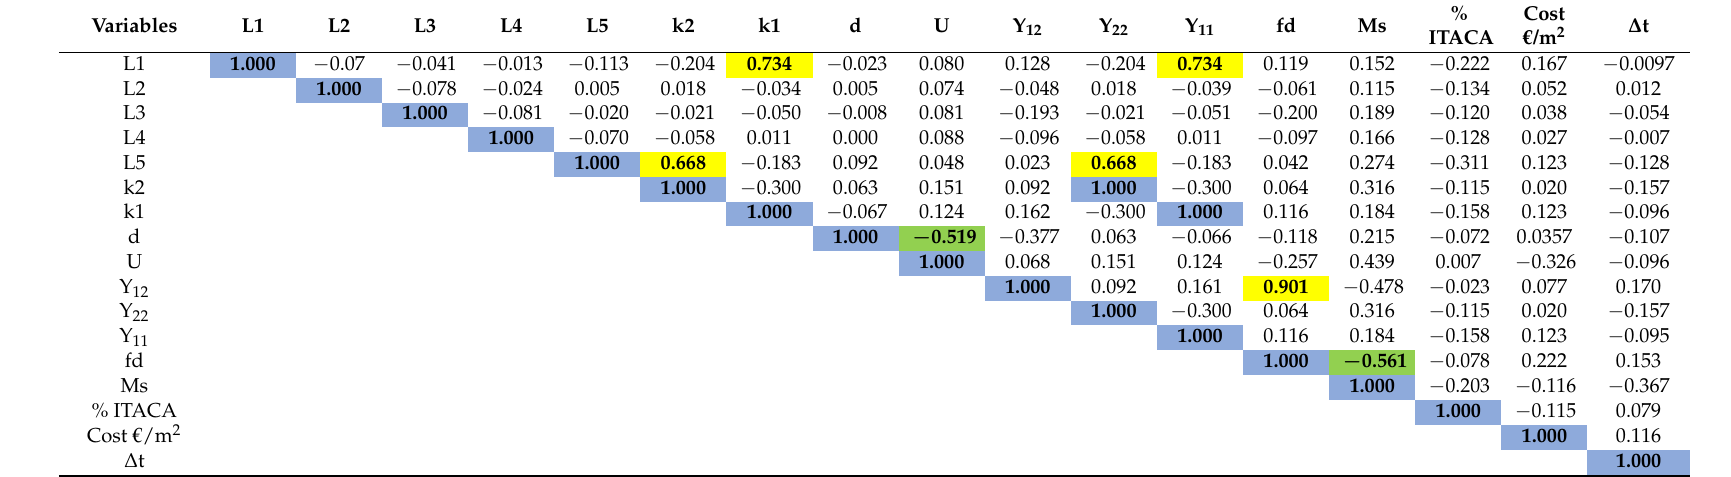
Table 7. Correlation matrix of the Pareto analysis for the variables of a generic